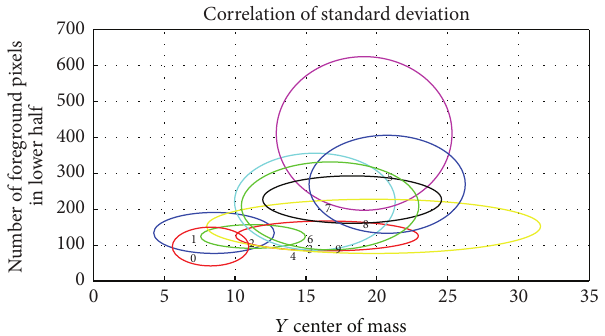
Figure 7: 2D SD spectrum distribution diagrams for Arabic/Farsi digits: “ 𝑌 Coordinate Centre of Mass” feature versus “Number of Foreground Pixels in Lower Half of Image”